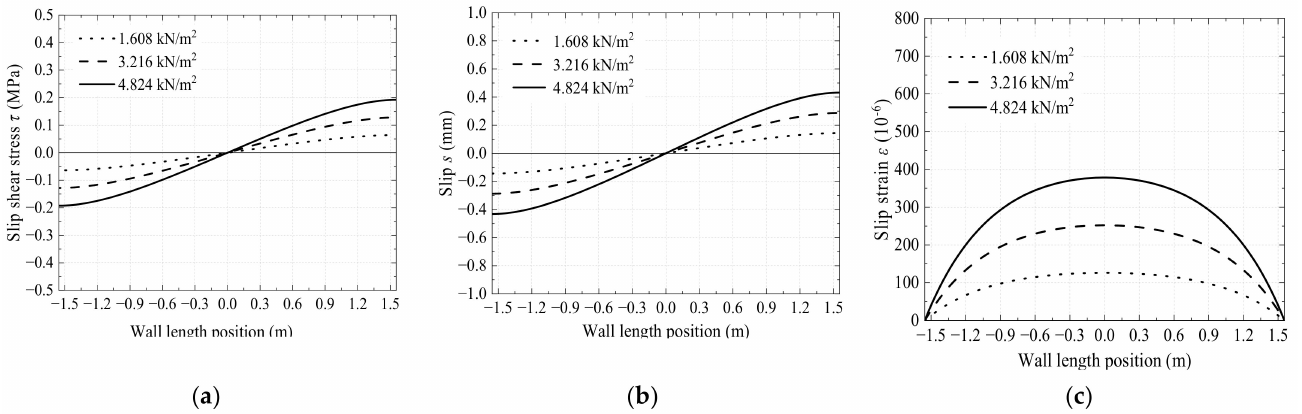
Figure 19. Distribution of mechanical parameters of slip along wall span. ( a ) Slip shear stress distribution. ( b ) Slip distribution. ( c ) Slip strain